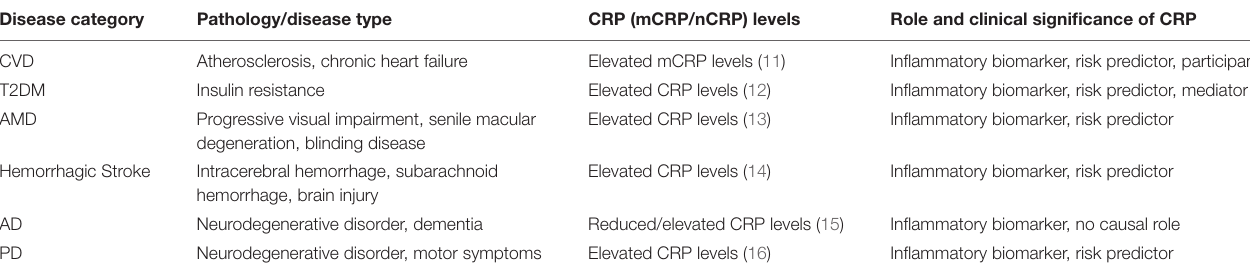
Table 1 | Chronic inflammatory diseases associated with CRP levels. Disease